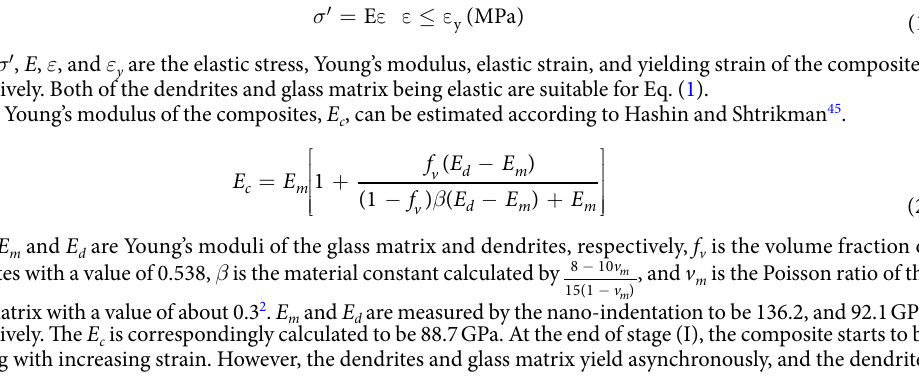
According to the above analysis, the stress states of the matrix and dendrites are variant at different stages. Under the circumstance of both phases being elastic, the stress-strain relations for the composites on the basis of Hooke’s law are: